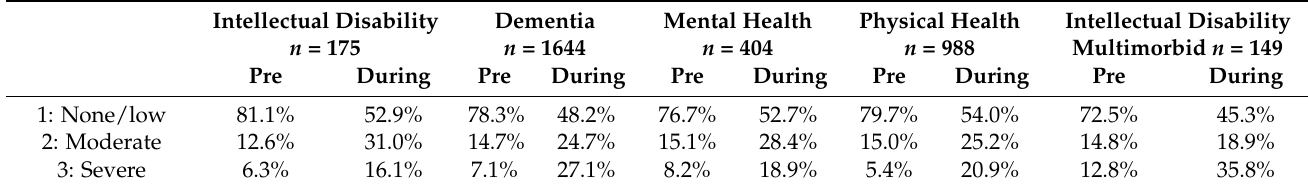
Table 2. Categorised UCLA loneliness scale pre- and during COVID-19 by Carer Type.